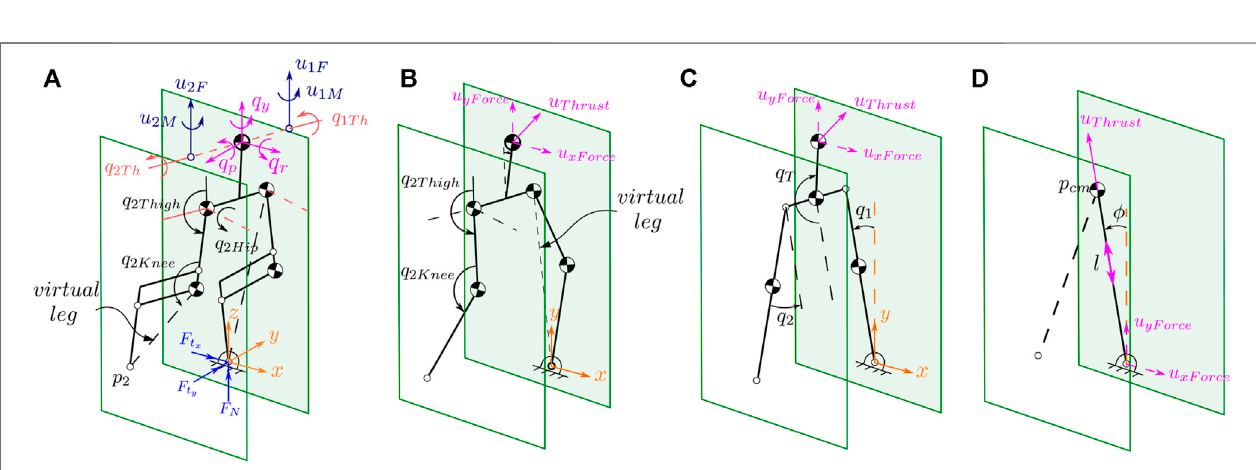
FIGURE 4 | Illustrates the stick diagram of the 3D and 2D models. The full 3D model is shown on the (A) . The equivalent fi ve-, three-link and Variable-Length, Inverted Pendulum (VLIP) models are shown in (B – D) , respectively.